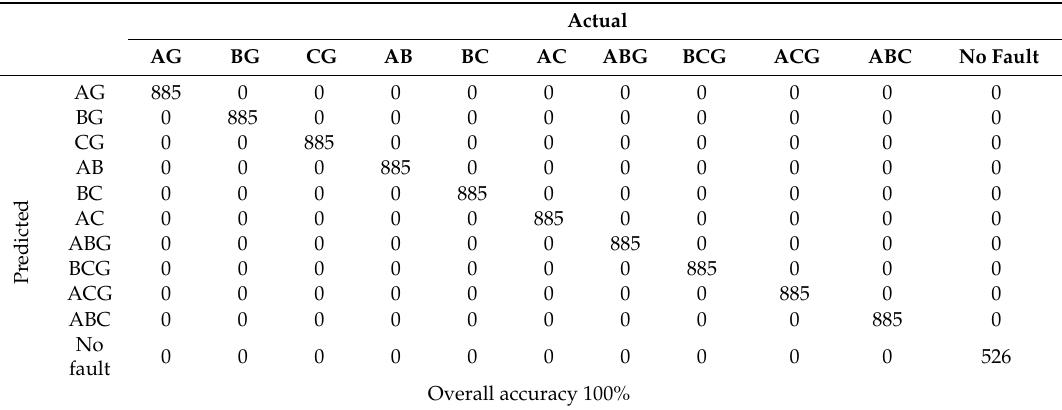
Table 2. Detection and classification confusion matrix for scenario